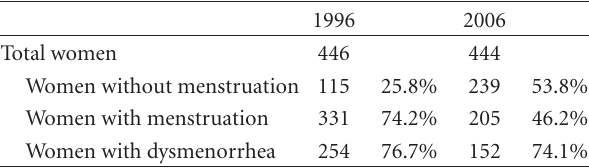
Table 3: Women with menstruation and